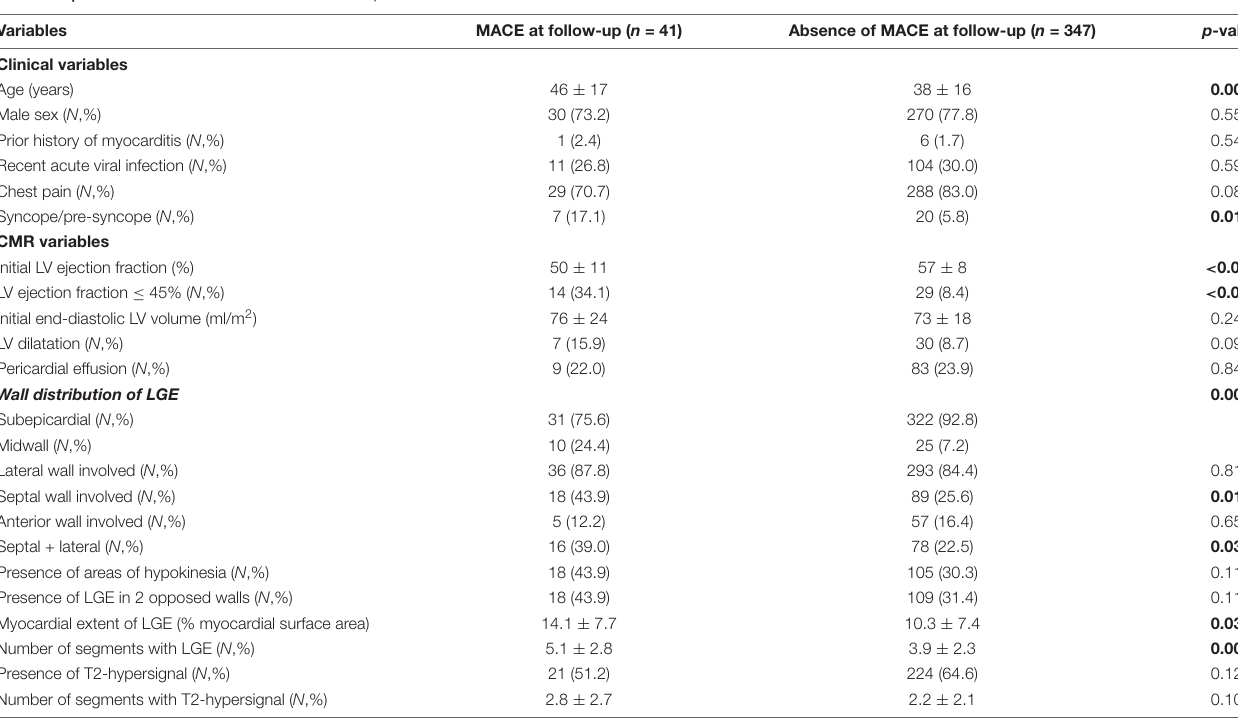
TABLE 4 | Patients with/without MACE at follow-up. Variables MACE at follow-up ( n = 41) Absence of MACE at follow-up ( n =